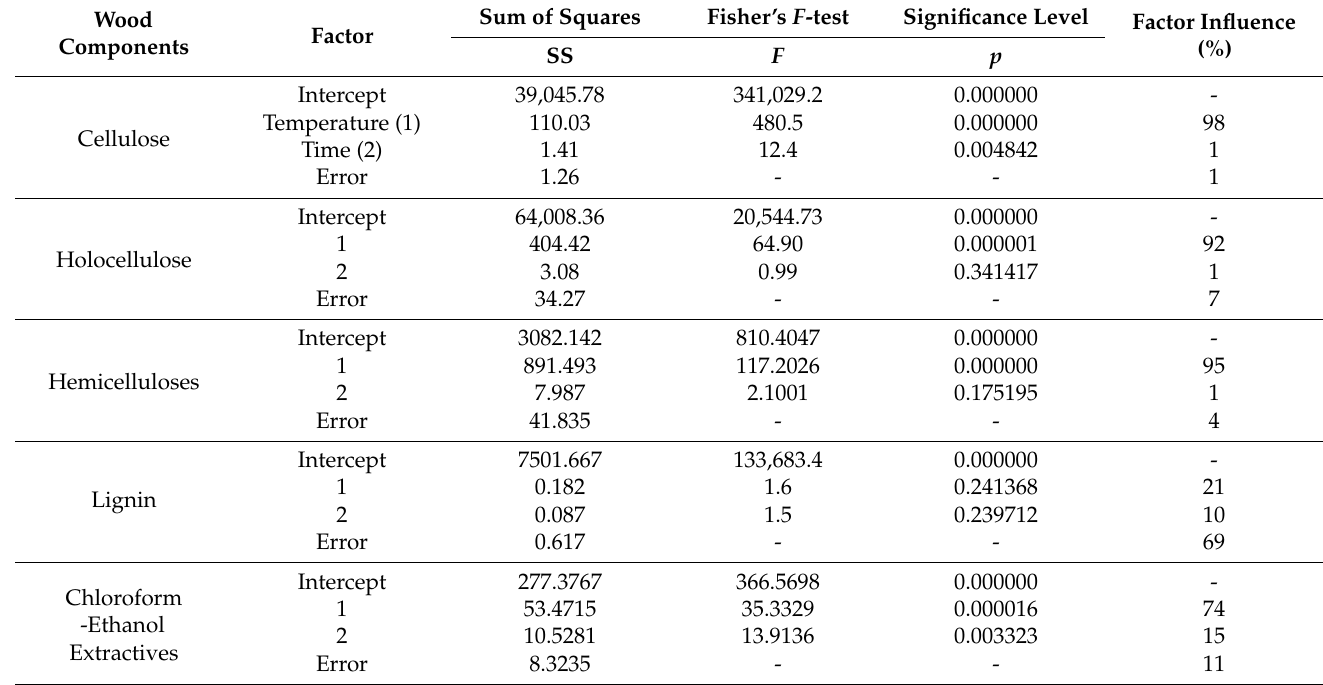
Table 3. ANOVA evaluation of the factors influencing the chemical composition of thermally modified in nitrogen atmosphere black poplar (Fischer’s F -test; p ≤